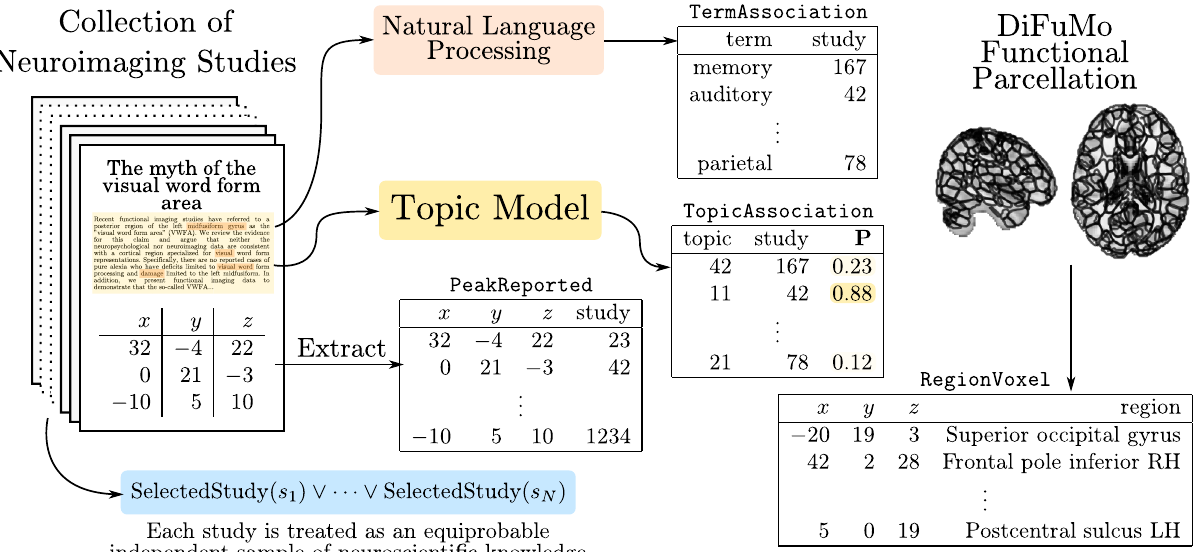
Figure 1. Representation of meta-analytic and functional parcellation knowledge using database tables in